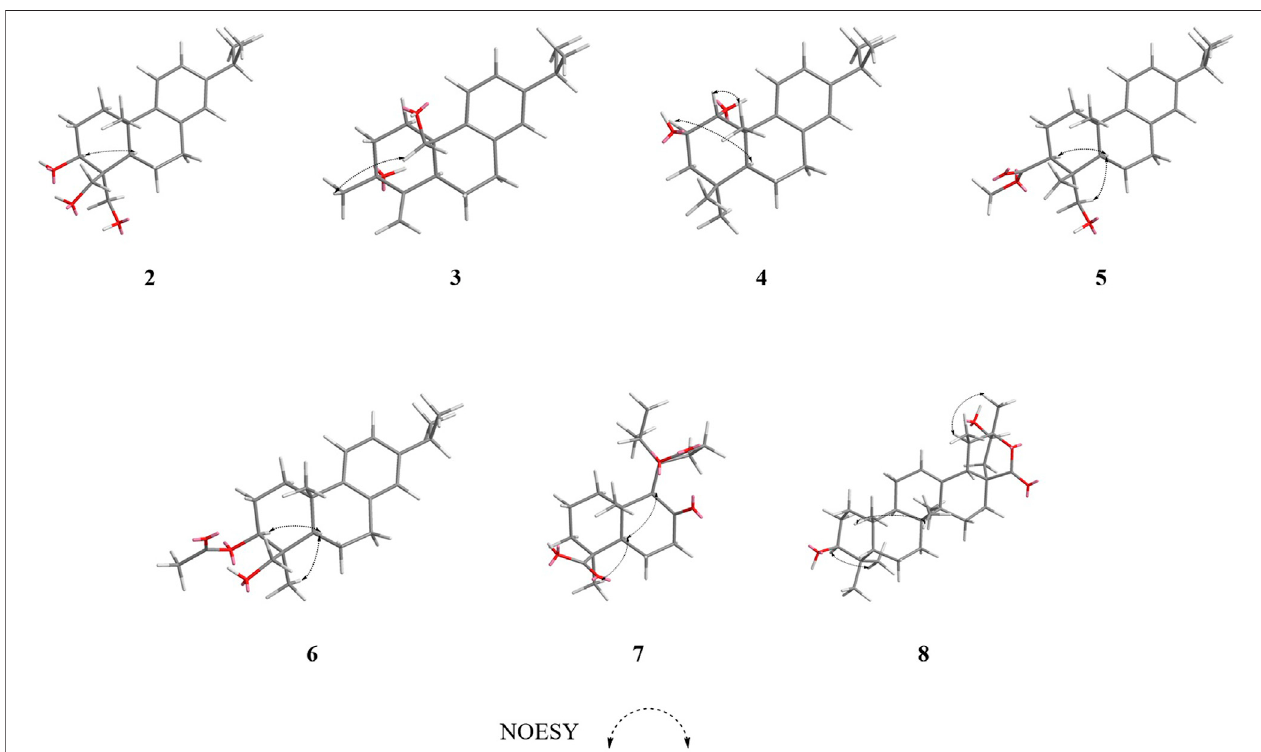
FIGURE 4 | Key NOESY correlations of compounds 2 – 8